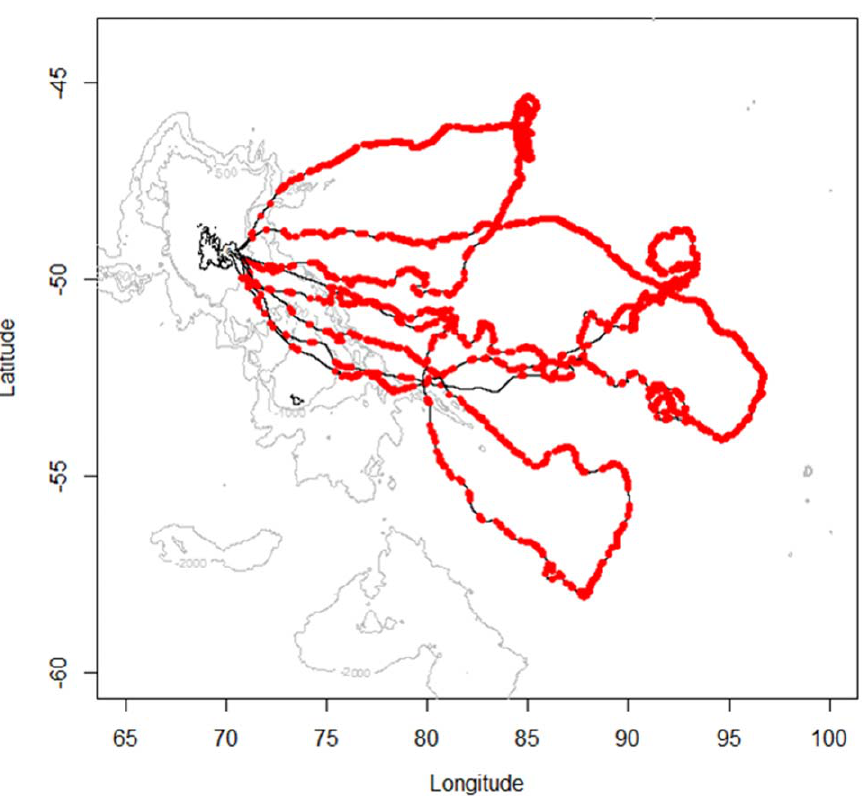
Figure 4. Post-breeding foraging trips of 4 female southern elephant seals. These females were equipped in October 2009 (solid black lines). Isobaths of 500 m, 1000 m and 2000 m deep are illustrated in light grey. Kerguelen island contour is depicted in black line. Red dots correspond to points into dives including at least one significant bioluminescence event (s).